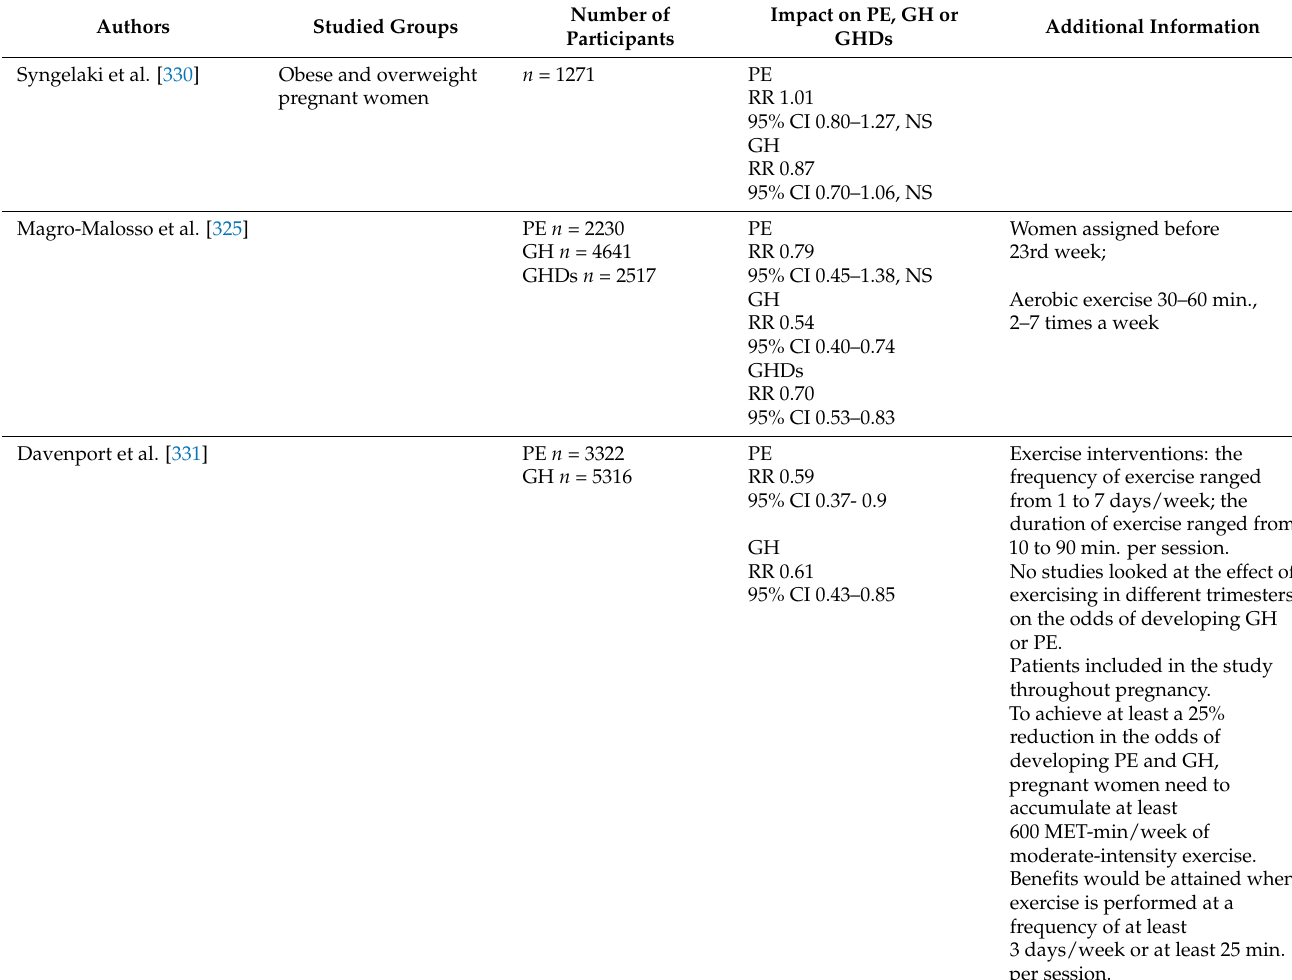
Table 3. Selected meta-analyses on the effect of exercise on PE